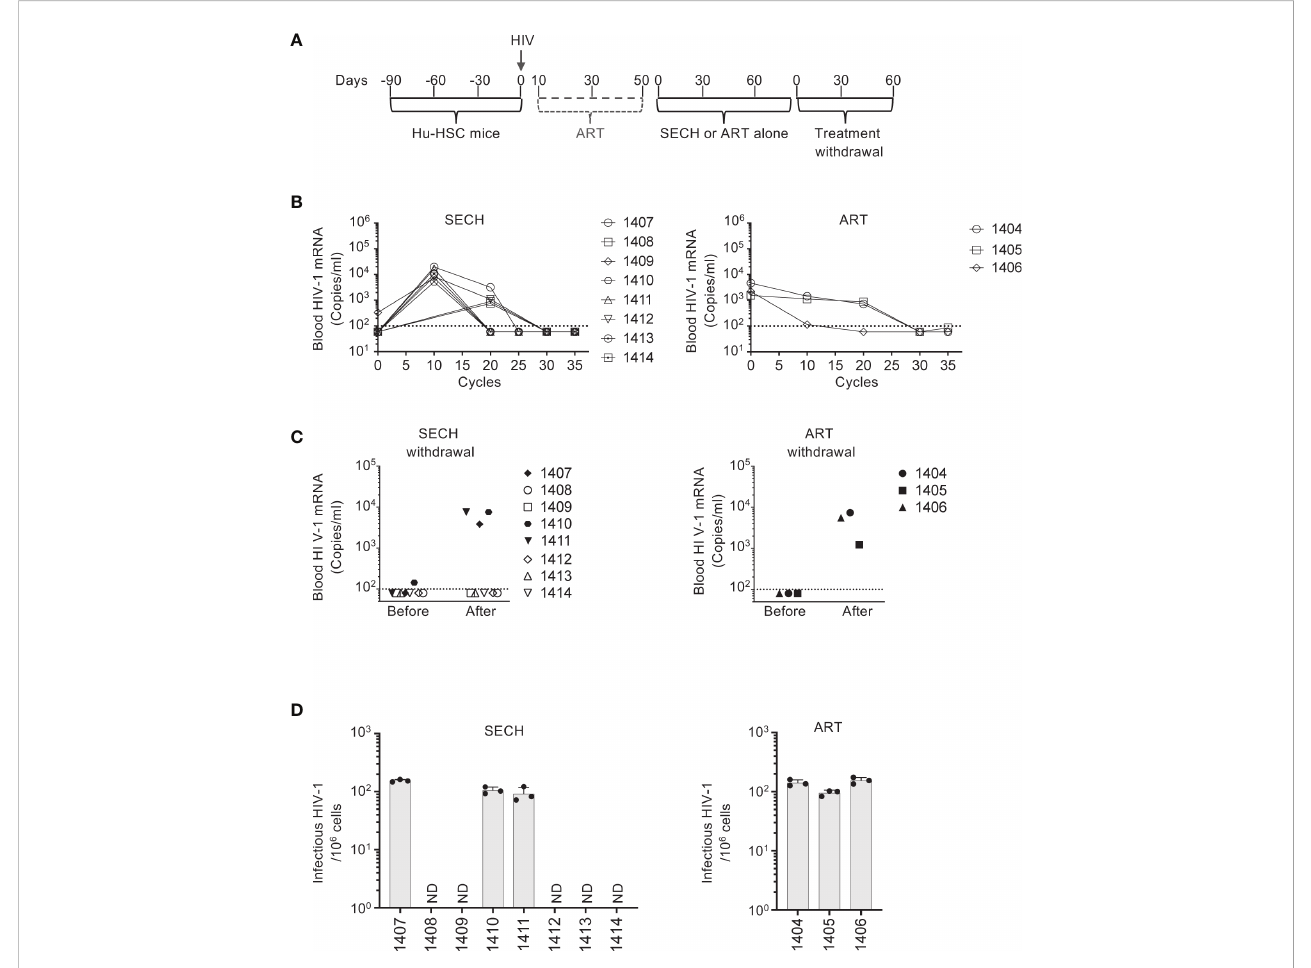
FIGURE 2 Clearance of HIV-1 infection in Hu-HSC mice. (A) A schematic diagram for SECH treatment of HIV-1-infected Hu-HSC mice. Three months after reconstitution with human CD34 + hemopoietic stem cells, Hu-HSC mice were infected with HIV-1 (AD8 strain, 1000 pfu/mouse), followed by suppressive ART treatments. After 40 days of suppressive ART, the mice were then treated by SECH or ART (35 cycles, 70 days), followed by withdrawal of treatments for 2 months. (B) HIV-1-infected mice were treated by SECH or ART alone (35 cycles). HIV-1 mRNA in the peripheral blood was determined as in Figure 1B. (C) ART and SECH treatments in (B) were withdrawn for 2 months. HIV-1 mRNA in the peripheral blood before and after withdrawal of treatment was determined. (D) Infectious HIV-1 in splenocytes from Hu-HSC miceafter withdrawal of treatments (C) was measured by TZA assays. ND, not